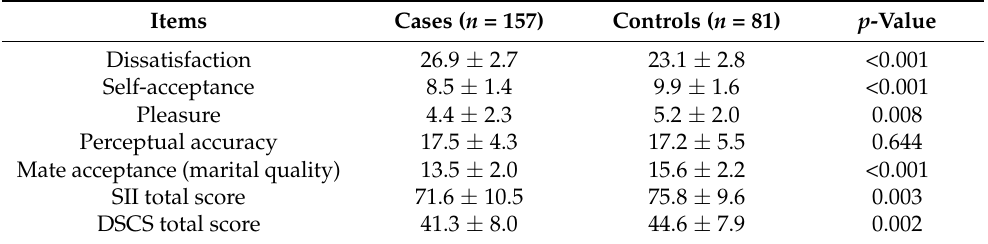
Table 4. Comparison of SII and DSCS survey results between women with thrombophilia and re- current pregnancy loss (cases), women with thrombophilia and recurrent pregnancy loss who achieved a normal pregnancy, and preterm or full-term birth (controls).